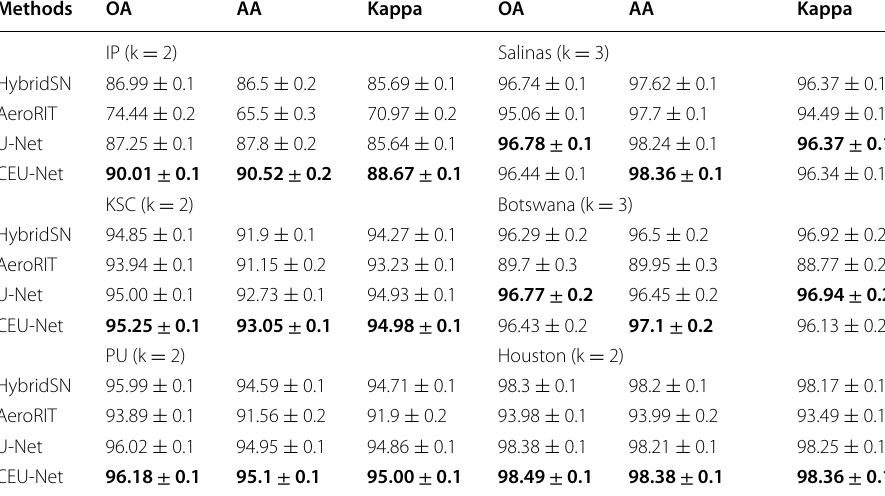
Highest performing values are highlighted in bold